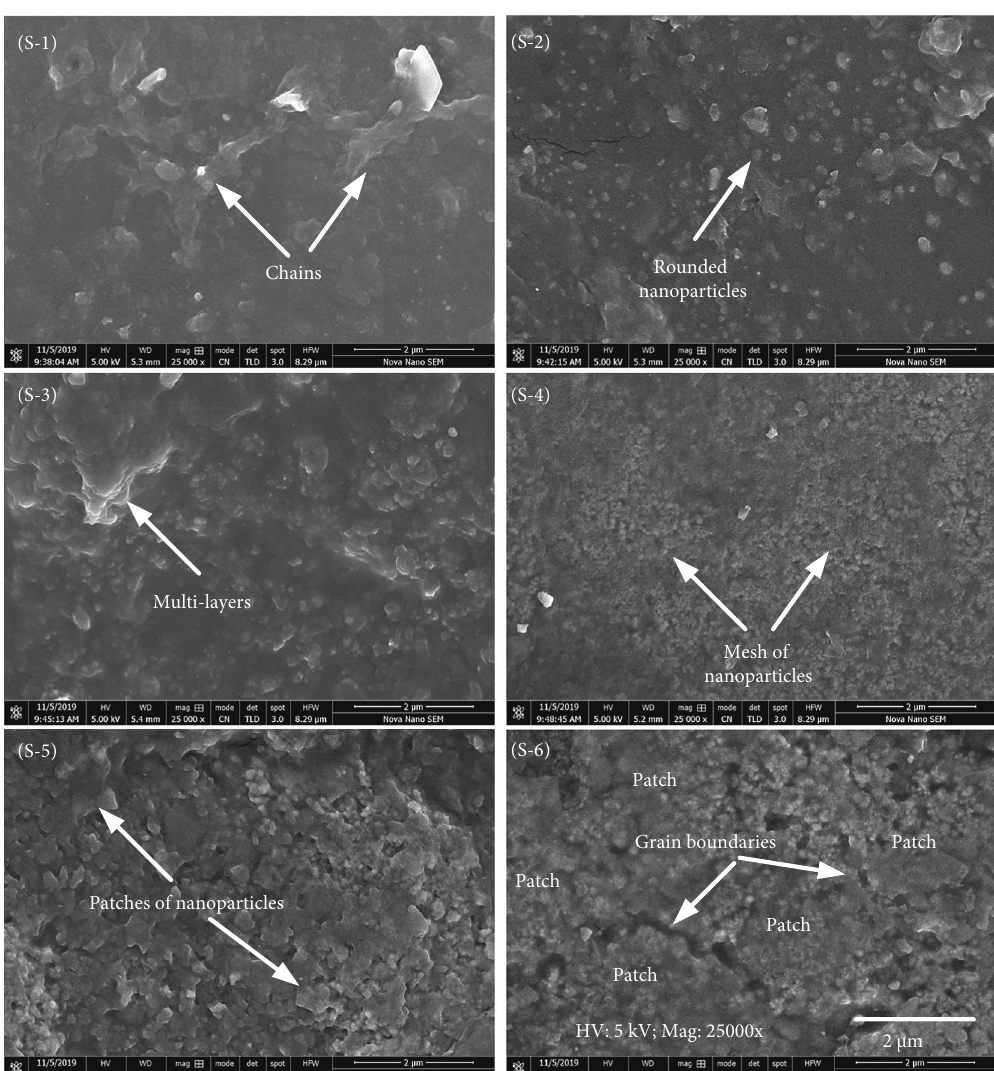
Figure 4: SEM microstructures of PVDF and PVDF-based NC FSs synthesized for various wt.% of silica